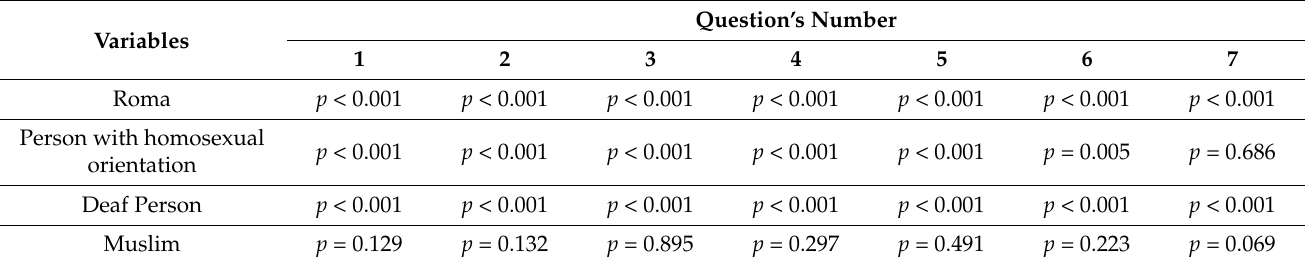
Table 5. Relationships between the respondents’ acceptance in the questions and the social group.